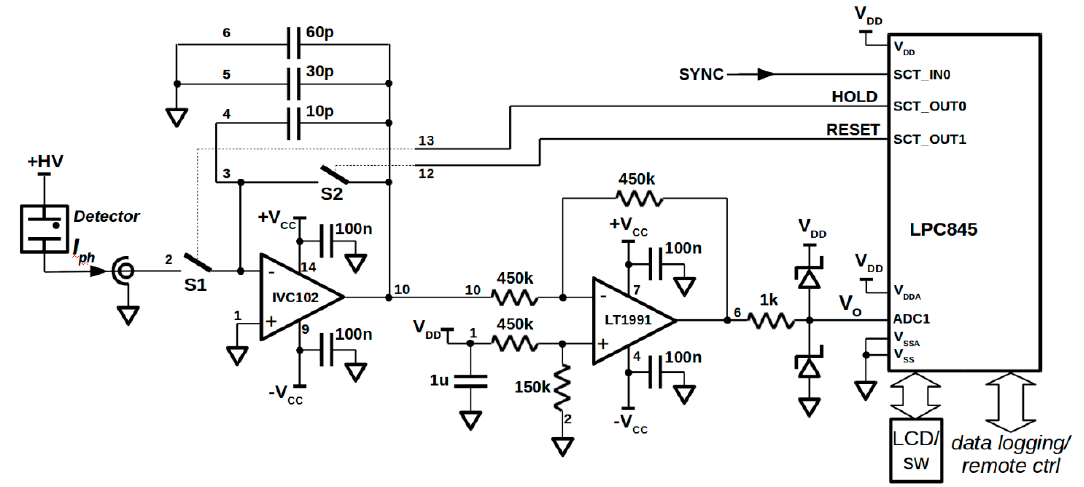
Figure 2. Schematic of the proposed prototype. A microcontroller unit based on the LPC845 is dedicated to A / D conversion, as well as timing control and external